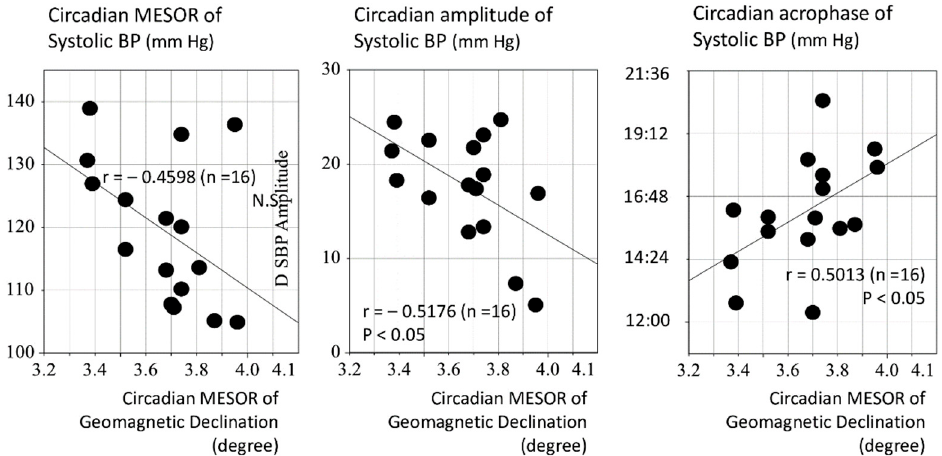
Figure 2. Effects of magnetic fluctuations on the circadian parameters of SBP on geomagnetically moderately disturbed days. Circadian MESOR and amplitude of SBP on disturbed days correlate negatively with statistical significance with the circadian MESOR of geomagnetic declination (left and middle, respectively), while the circadian acrophase of SBP is delayed (right). These results suggest that the circadian parameters of systolic BP are affected by magnetic fluctuations on moderately disturbed days, i.e., about 3 times higher on moderately disturbed days compared to quiet days.